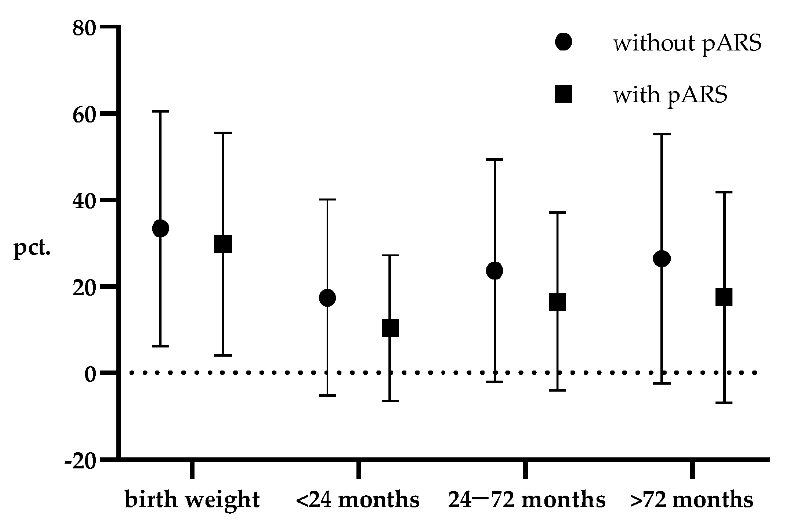
Figure 1. Mean of weight percentiles of patients with and without preventive anti-reflux surgery at different time intervals. Error bars indicate SD. pARS, preventive anti-reflux surgery; pct., percentile. Table 4. Percentiles and z-scores of body weight at different time intervals.